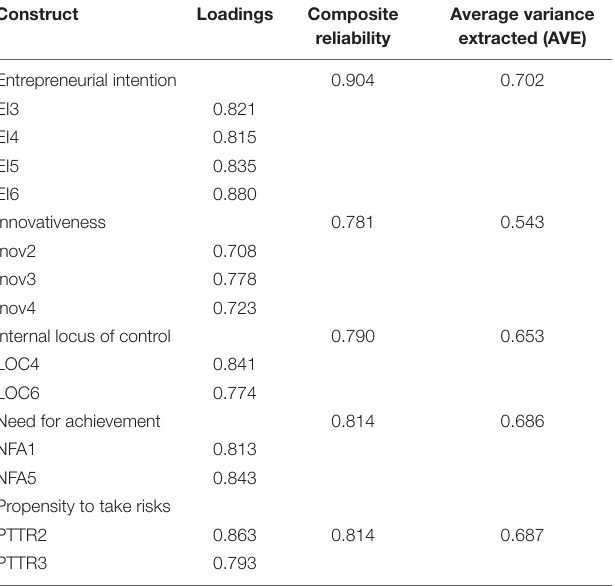
TABLE 3 | Reliability and convergent validity.